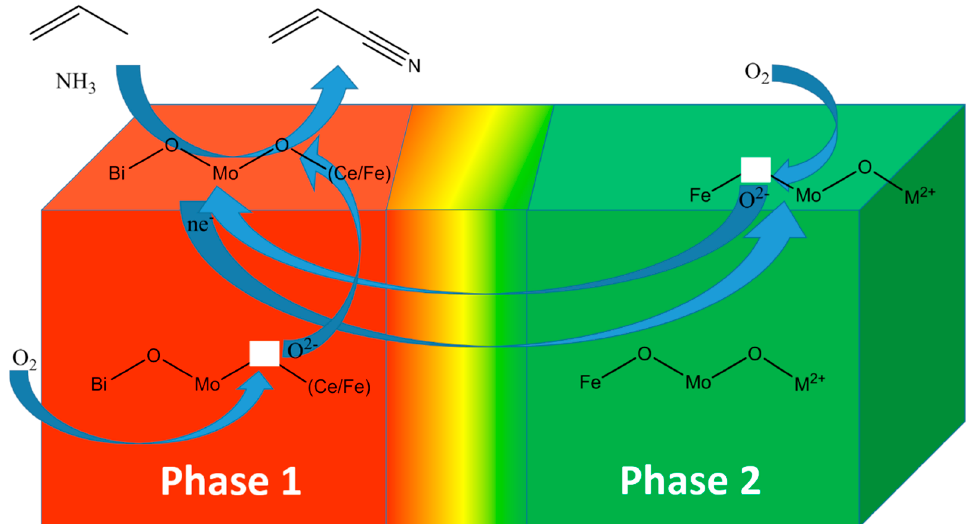
Figure 2. Schematic representation of multifunctionality in single and multiphase in an ammoxidation catalyst system [48].